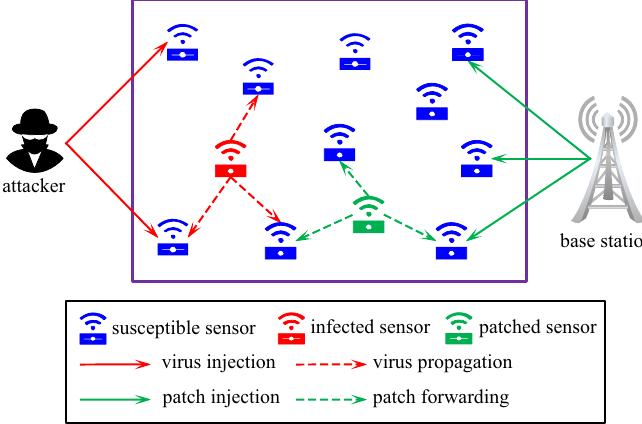
Figure 2. A diagram of patch injection and forwarding in the WSN shown in Figure